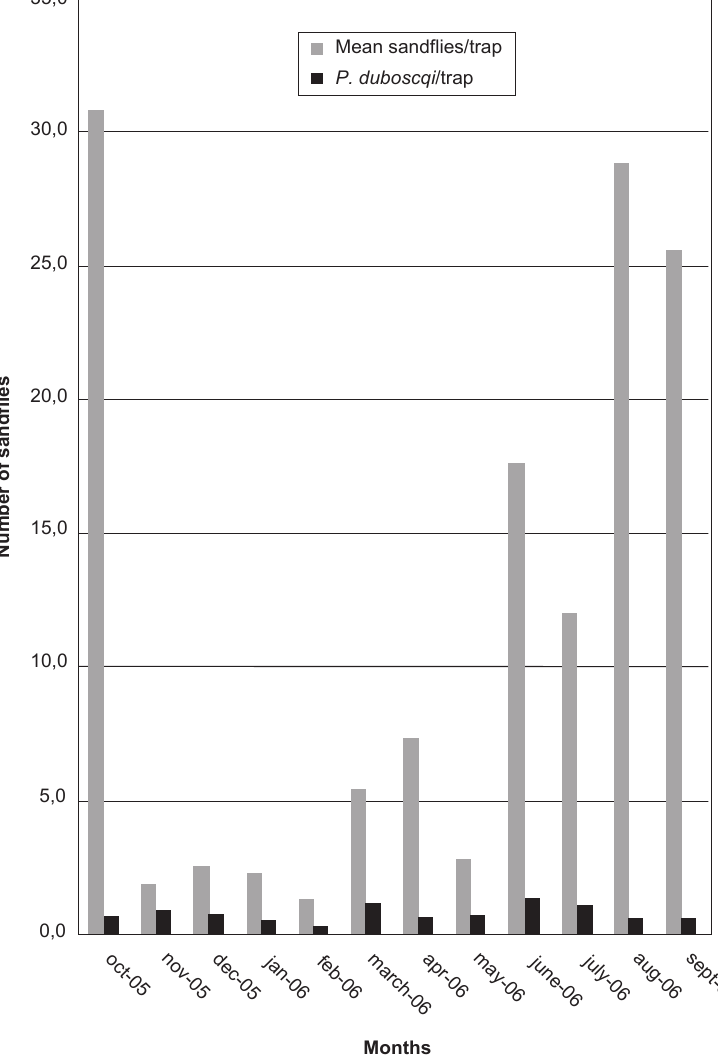
Fig. 1. – Number of trapped sandflies during the longitudinal study (the dramatic percentage of Ser- gentomyia versus Phlebotomus genus is